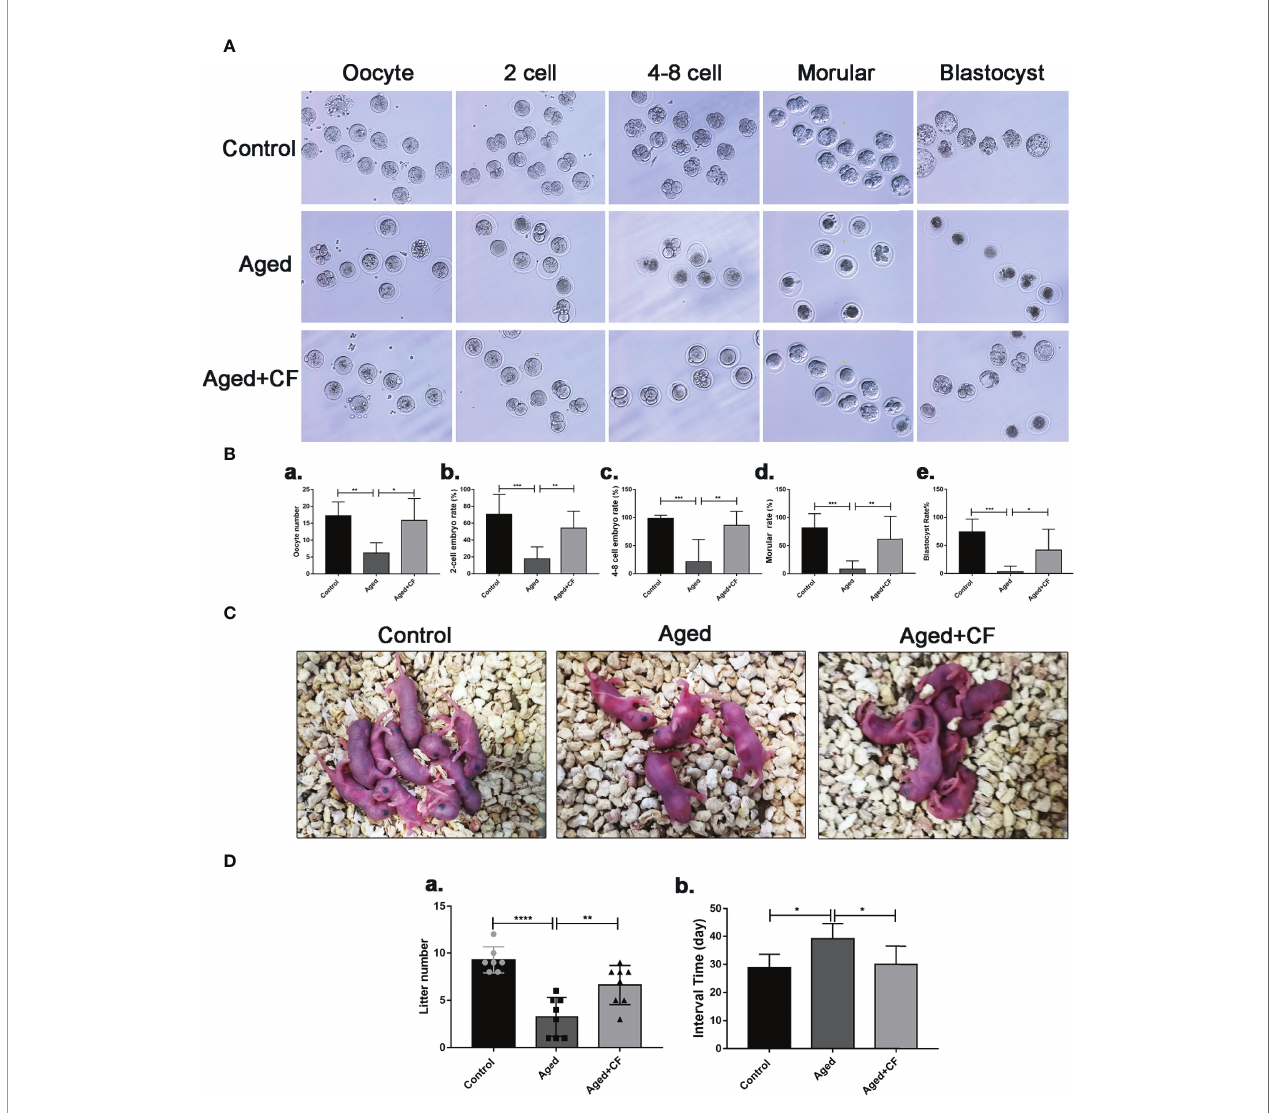
FIGURE 2 | The impact of CEFFE treatment on fertility restoration. (A) Representative morphology of embryo development in different groups, including the oocyte, 2 cell embryo, 4-8 cell embryo, morula, and blastocyst stages. (B) Total number of oocytes and the rate of 2 cell embryo, 4-8 cell embryo, morula, and blastocyst were recorded in different groups (n=6-7). (C) Representative images of litters from Control, Aged, and Aged+CF groups (n=7-8). (D) Statistical analysis of litter numbers (a) and the interval time (the time from mating to birth) (b) Data are represented as the mean ± SD, * P < 0.05, ** P < 0.01, *** P < 0.001, and **** P <